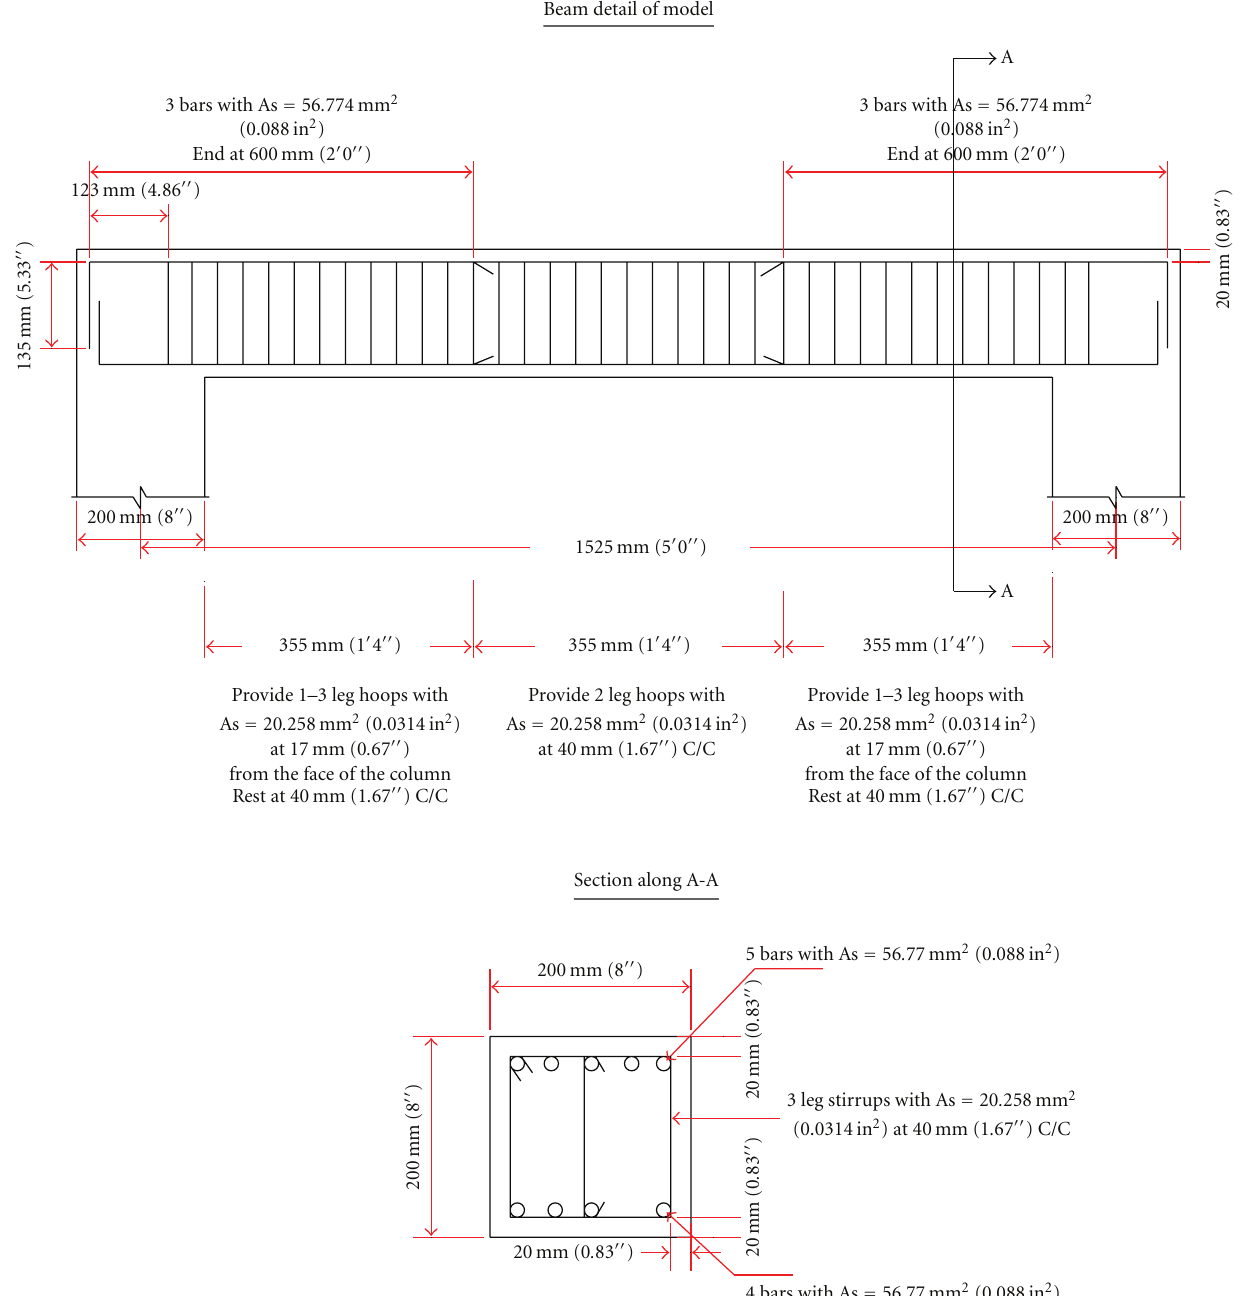
Figure 6: Reinforcement details of the 1/3rd scaled beam